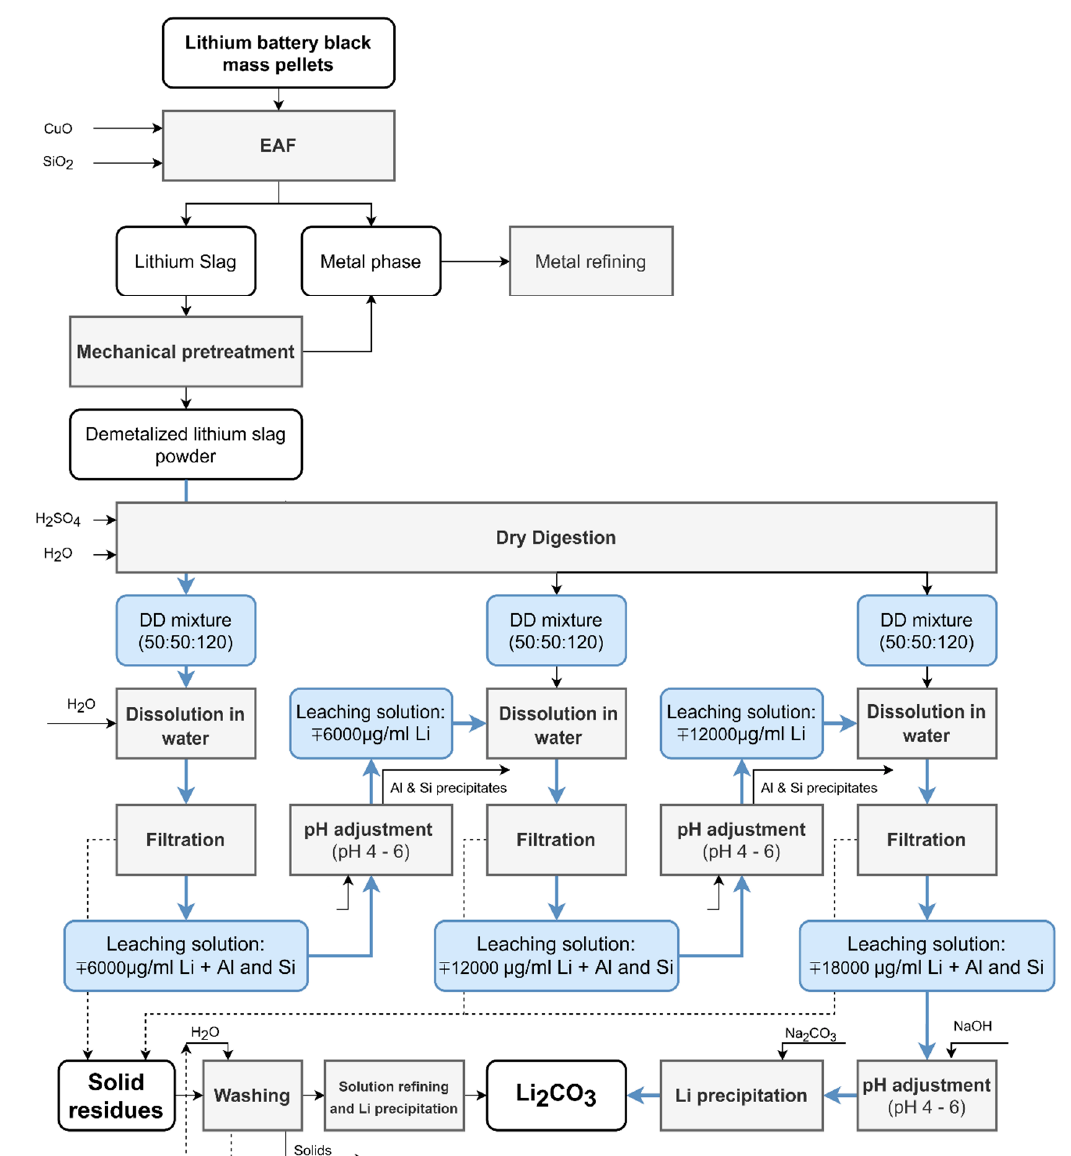
Figure 25. Proposed approach for lithium slag recycling by dry digestion method.